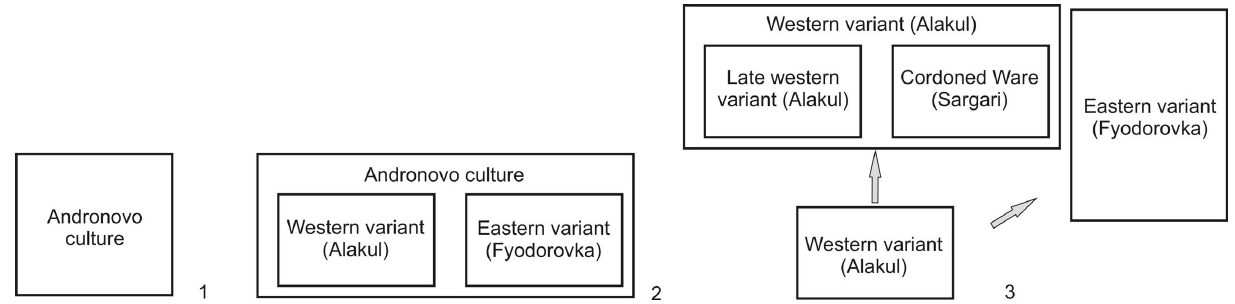
Figure 3: Schemes of cultural genesis in the period of formation of the Andronovo problem: 1) S.A. Teploukhov (1927), 2) M.P. Gryaznov